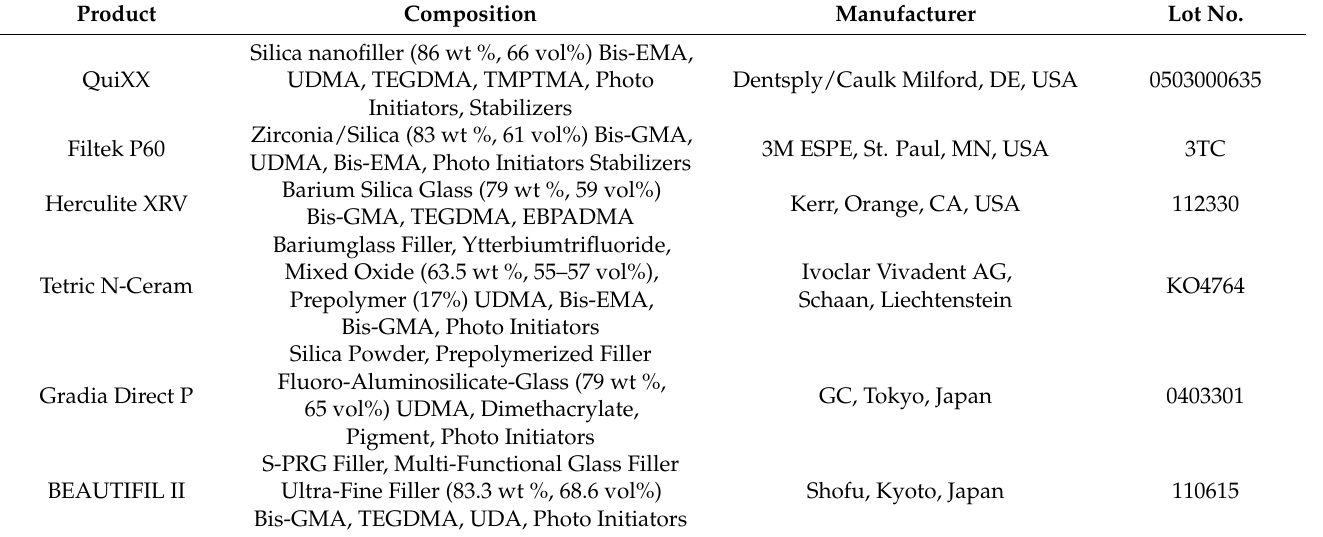
Table 4. Light-activated restorative materials